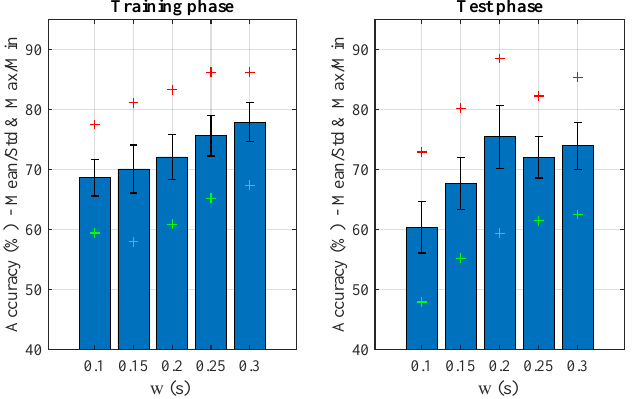
Figure 12. Summary of self-organizing-map (SOM) performance search results.